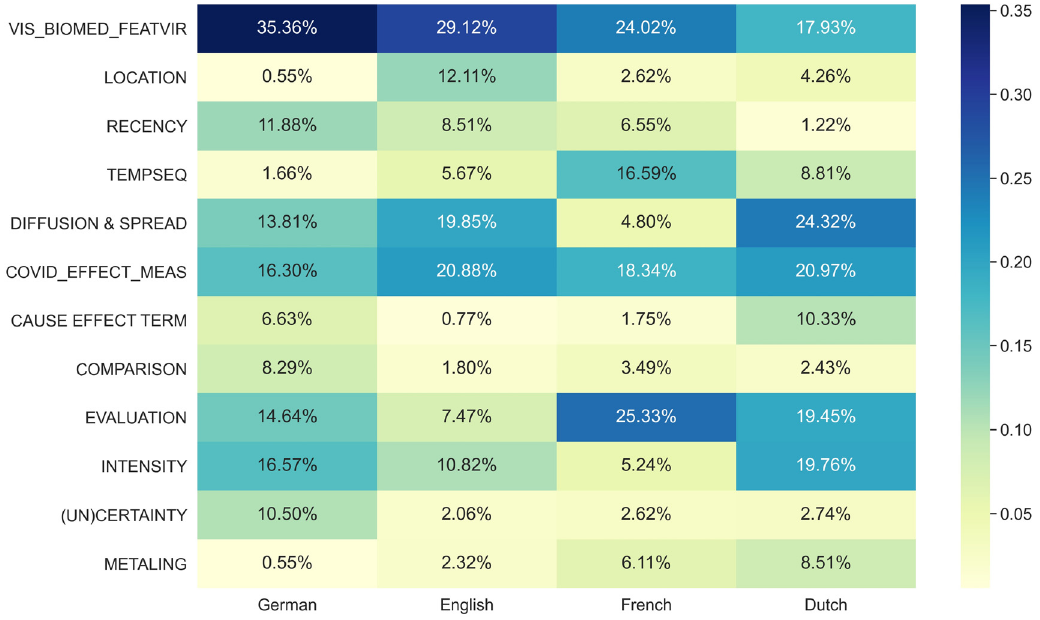
Figure 2: Heatmap of semantic categories ( expressed in relative frequency ) per language, across all months ( contrastive perspective )